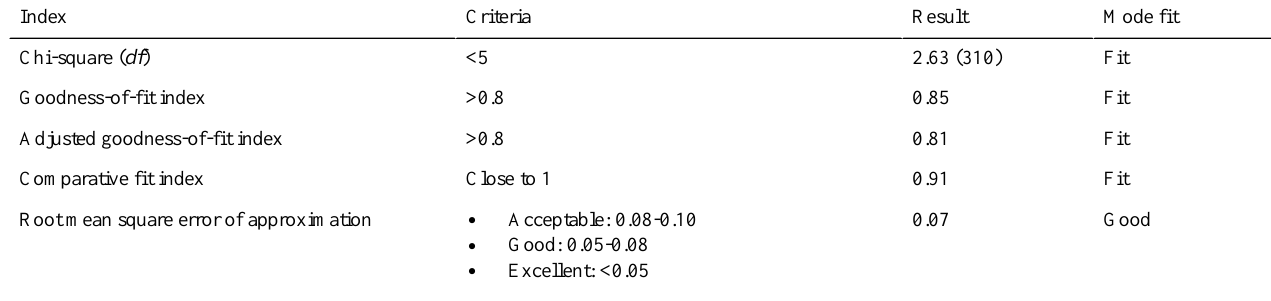
Table 5. Results of overall model fit.